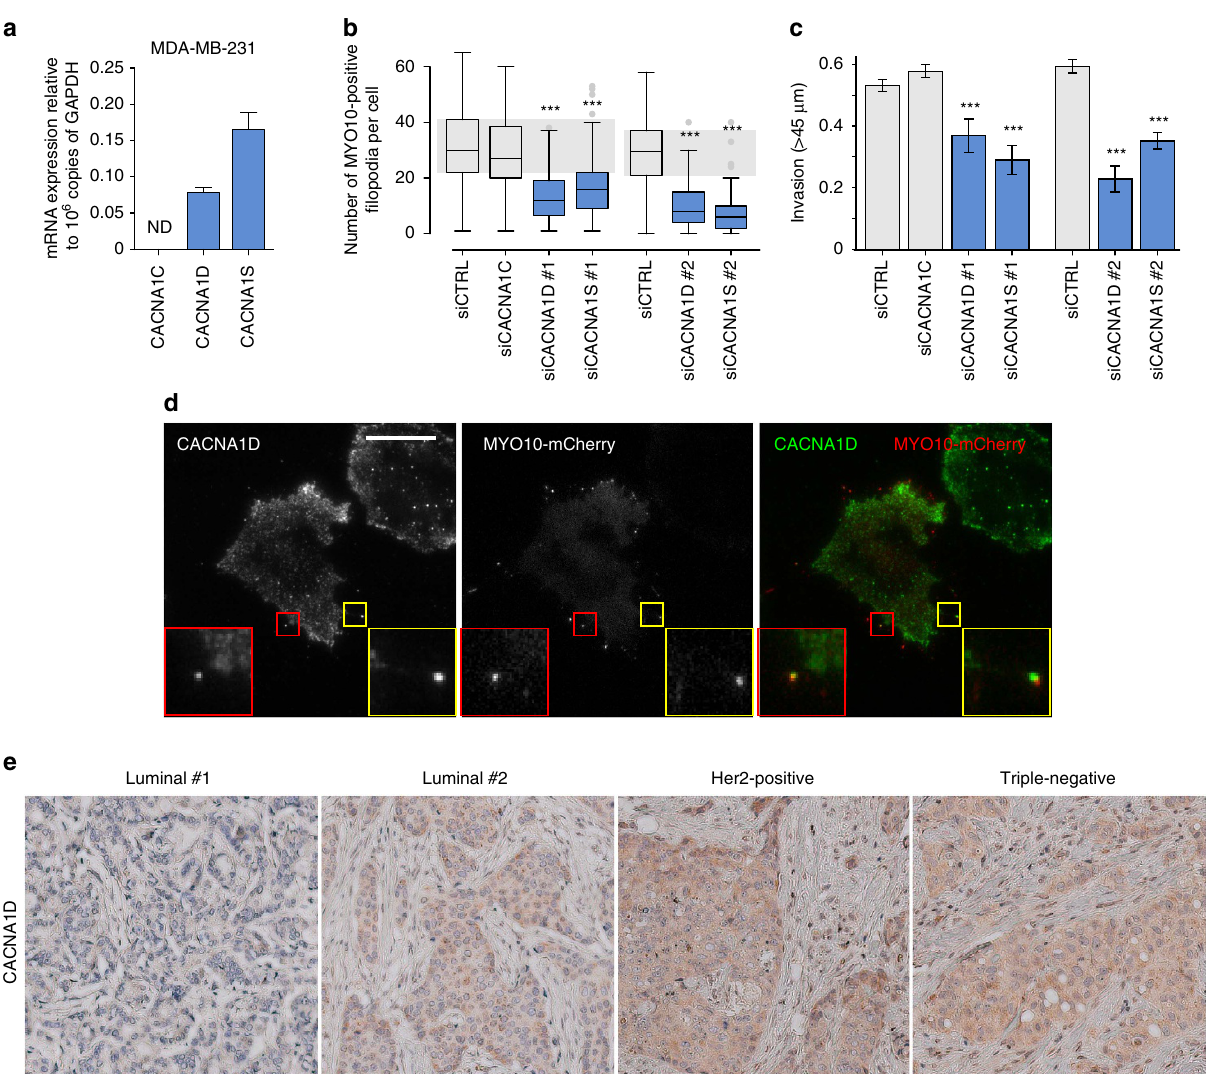
Figure 3 | CACNA1D and CACNA1S regulate filopodia formation and cancer cell invasion. ( a ) Relative expression of CACNA1C , CACNA1D and CACNA1S in MDA-MB-231 cells as determined by Q-RT-PCR ( n ¼ three biological repeats). ( b ) MDA-MB-231 cells previously silenced for CACNA1D or CACNA1S using multiple RNAi oligos as indicated and transiently expressing MYO10-GFP were plated on FN for 2h, fixed and the number of MYO10-positive filopodia per cell was quantified ( n 4 95 cells, three biological repeats *** P value o 2.4 (cid:3) 10 (cid:2) 10 ). A smartpool of oligos targeting CACNA1C was used as an additional control as no CACNA1C expression was detected in these cells. ( c ) MDA-MB-231 cells previously silenced for CACNA1D or CACNA1S using multiple oligos were seeded into an inverted invasion assay and allowed to invade for 48h. Relative invasion over 45 m m was quantified ( n ¼ three biological repeats, *** P value o 8.9 (cid:3) 10 (cid:2) 3 ). ( d ) MDA-MB-231 cells transiently expressing MYO10-mCherry were plated on FN for 2h, stained for endogenous CACNA1D and imaged on a TIRF microscope (scale bar, 20 m m). ( e ) Representative images of various types of breast cancer tissue samples stained for CACNA1D (scale bar, 200 m m). P values were calculated using Student’s t -test (unpaired, two-tailed, unequal variance). All error bars represent s.e.m.